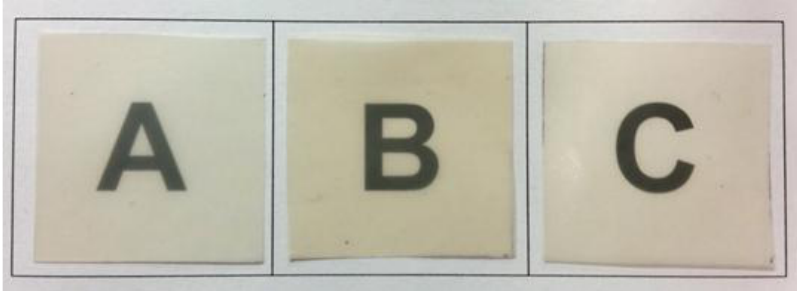
Figure 4. Contact transparency pictures of films. ( A ) poly(3-hydroxybutyrate-co-3 mol %-3- hydroxyvalerate) (PHBV3); (B) multilayer; (C) active multilayer.